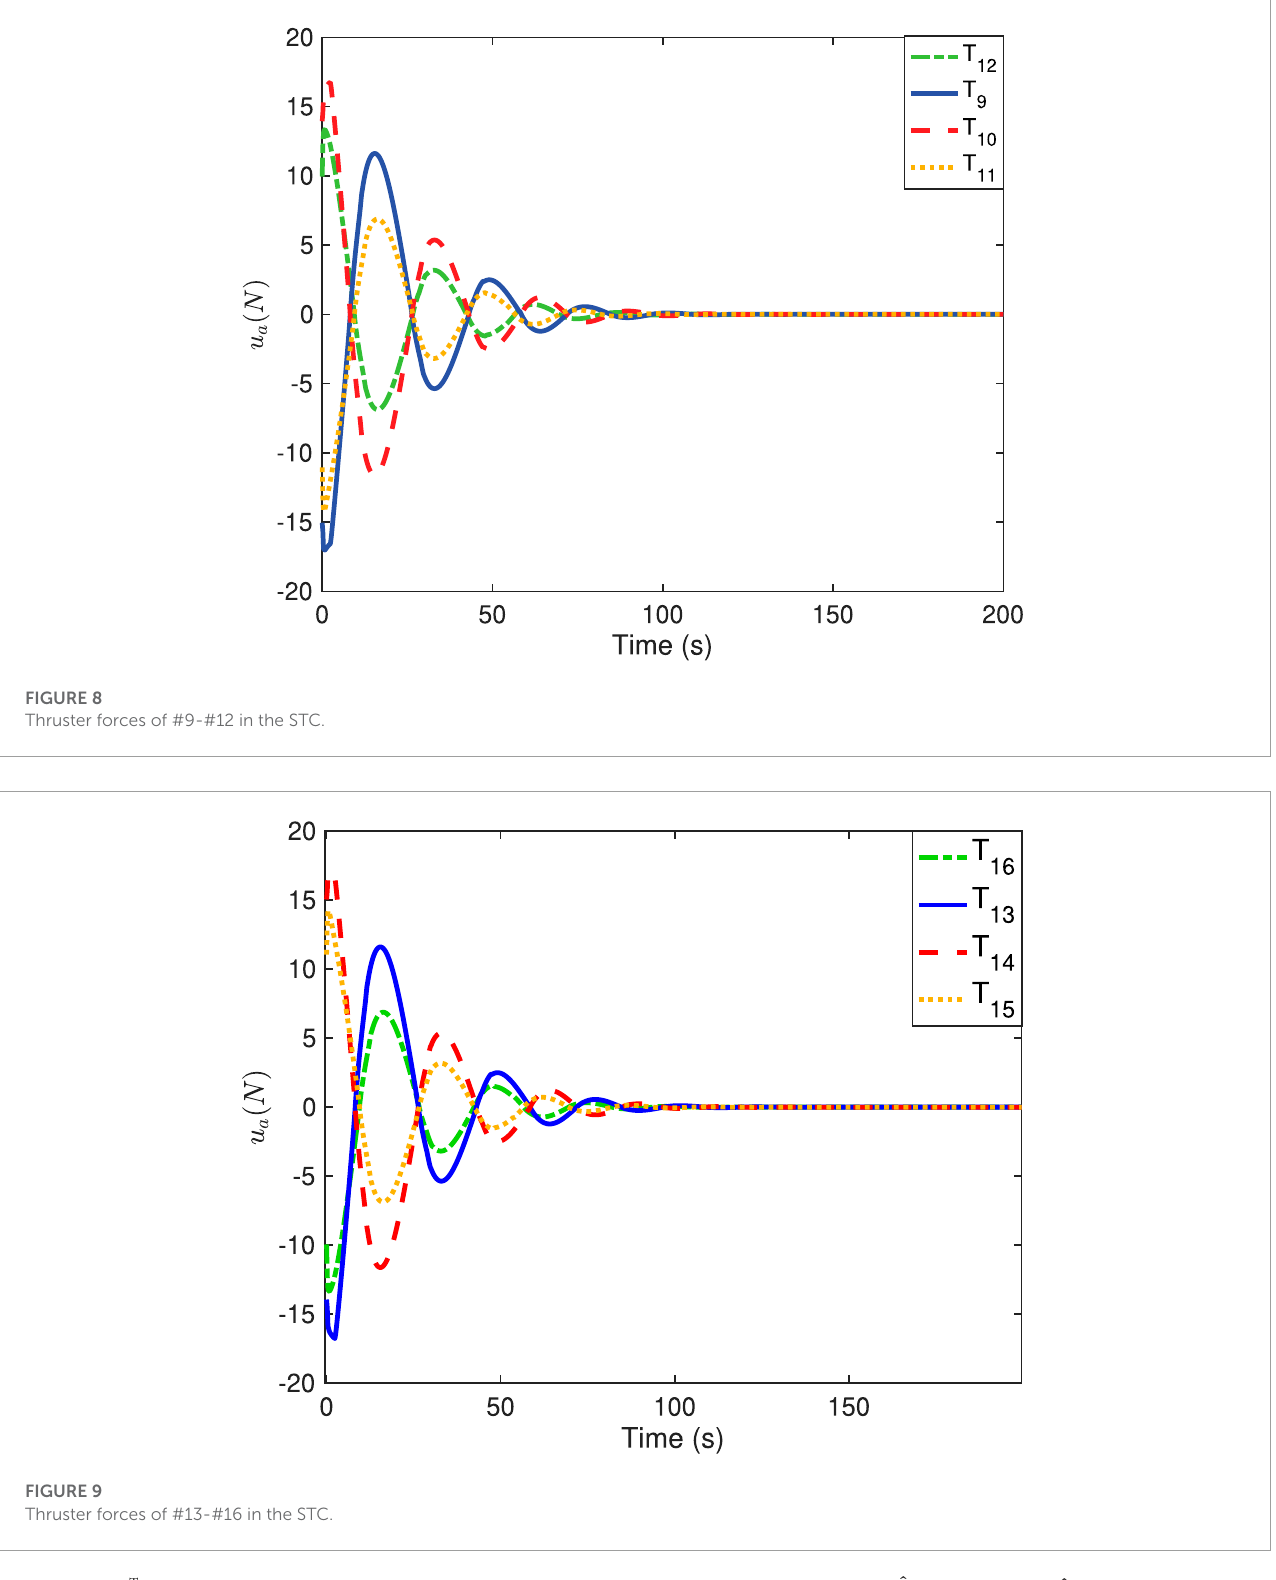
Figure 1 ; Figure 2 representthetimeresponsesofrelativeposition and attitude errors under the effect of the three controllers. Under the same initial values, the relative position errors driven by the